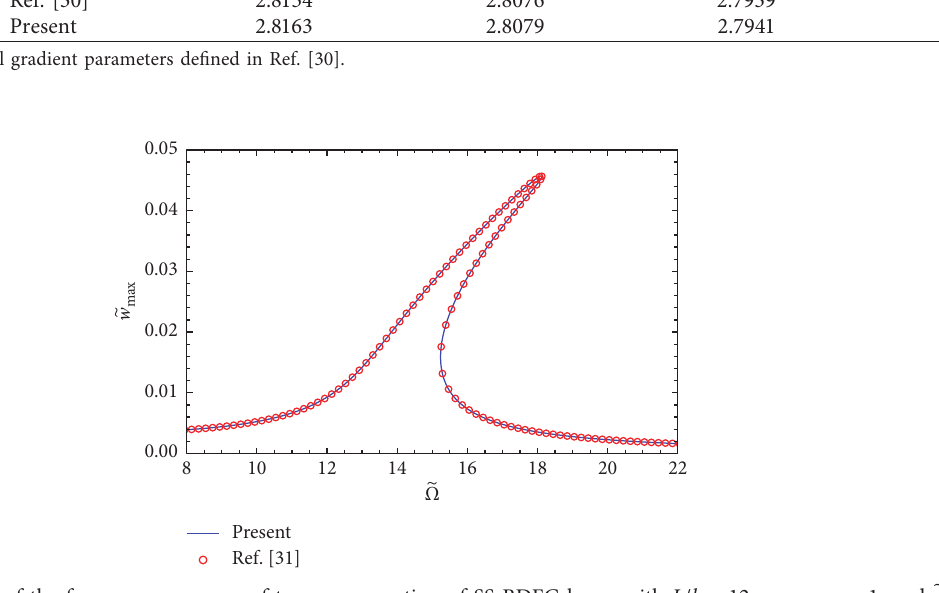
� m � 1, and 􏽥 f � 0 . 5. x z